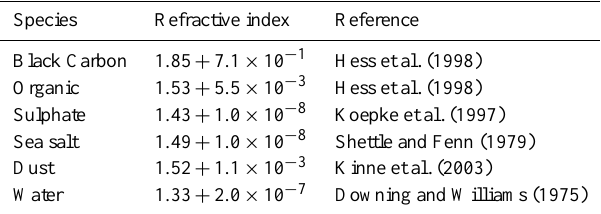
Table 5. Complex refractive indices by compound at λ =